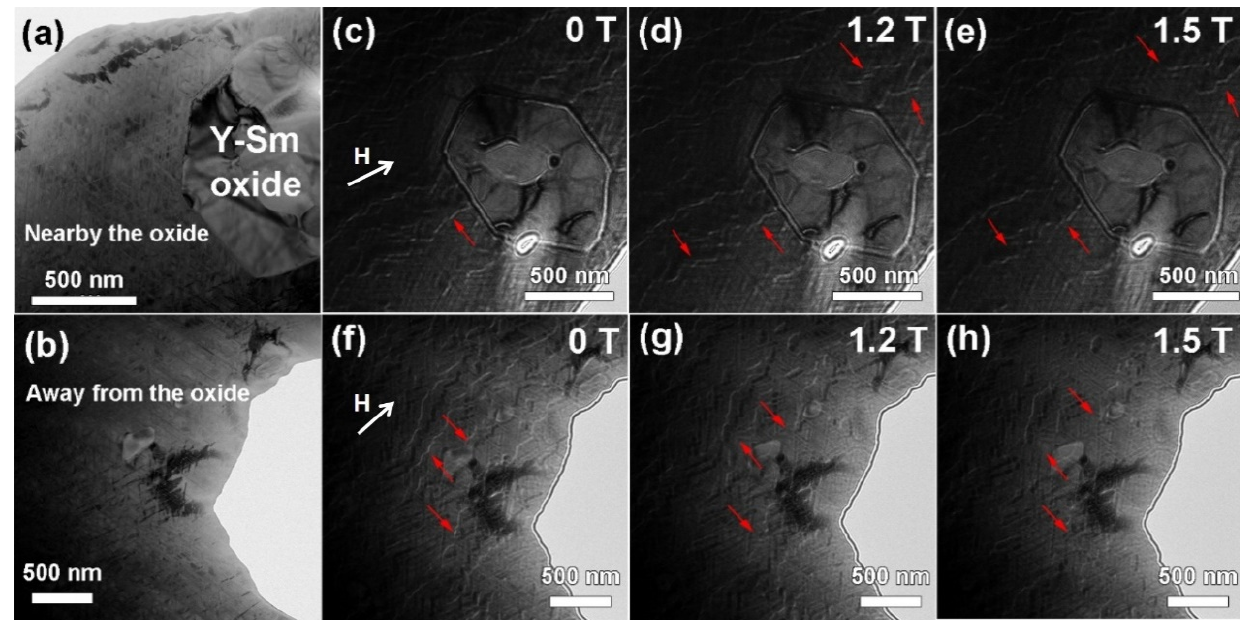
Figure 7. Fresnel Lorentz images for ( a , c – e ) the matrix nearby the Sm-Y oxide and ( b , f – h ) away from it in magnets with 0.5 wt.% Y 2 O 3 addition at remanence states after external fields of 0 T, 1.2 T and 1.5 T.